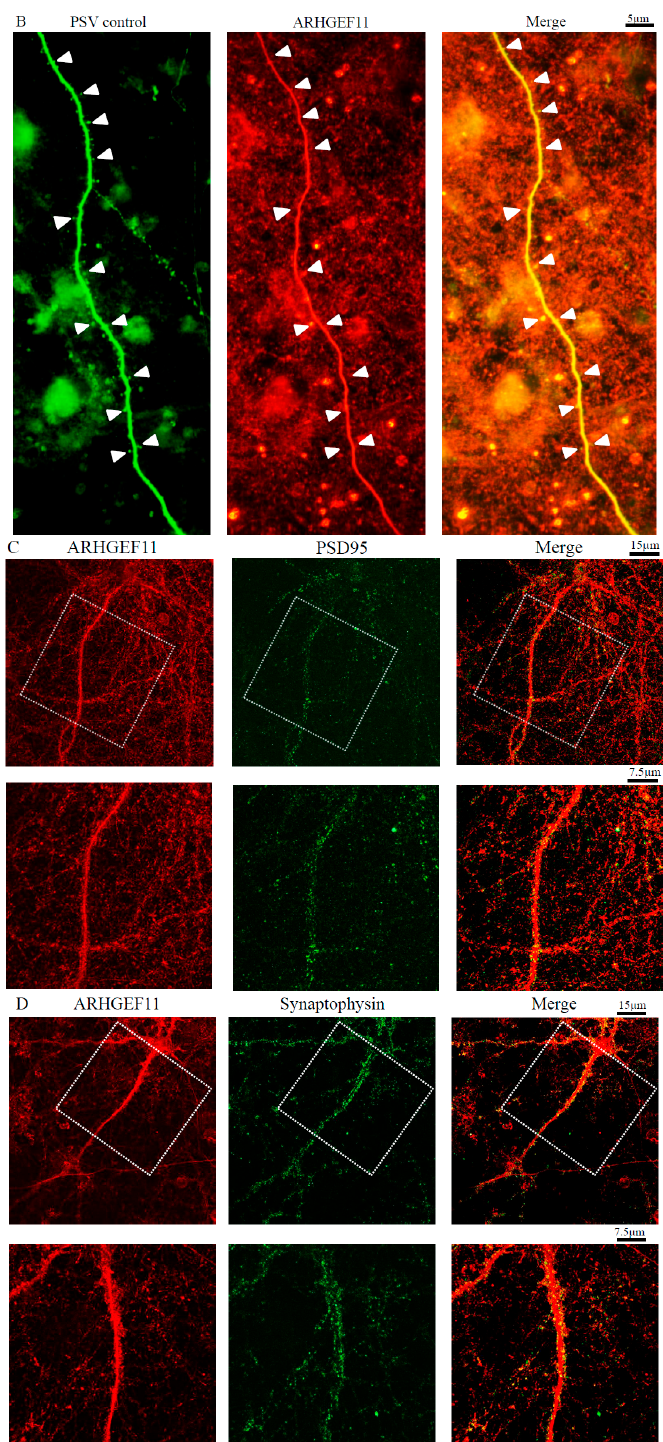
Figure 3. Localization of endogenous ARHGEF11 in cortical primary neurons. Immunofluorescent cell staining was conducted. Expression of ARHGEF11 in primary cortical neurons at 28 day in vitro (D.I.V.): ARHGEF11 (red) located in the dendrite and dendritic spine ( A , B ); ARHGEF11 (red) was colocalized with PSD-95 (green) at the punctate structures of dendrites ( C ); and ARHGEF11 (red) was colocalized with synaptophysin (green) ( D ). Three independent experiments were conducted. Dotted rectangles indicate the area of lower figure. White arrows indicate merged spines.